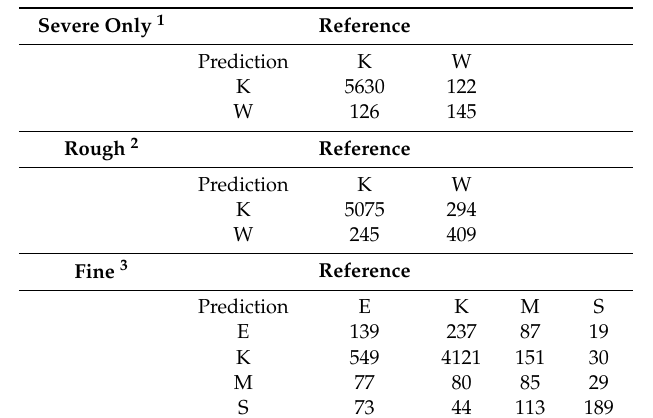
Table 8. Confusion matrices for random forest classification for the cells, grouped into the three categories of “severe only”, “rough”, and “fine”.